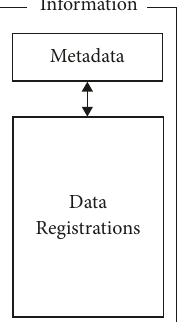
Figure 1: The relationship between data elements and